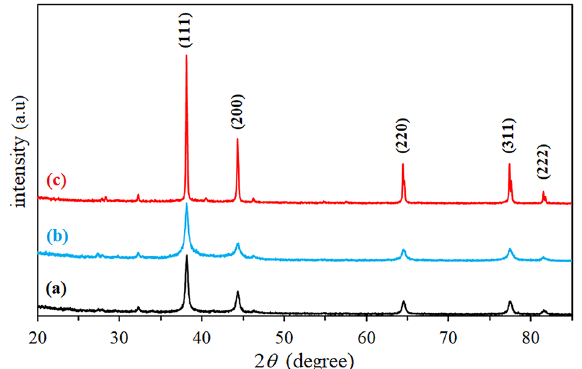
Figure 5. XRD spectra of ( a ) AgNP-W, ( b ) AgNP-F, ( c ) AgNP-S. Peaks are appeared at 111, 200, 220, 311 and 222.